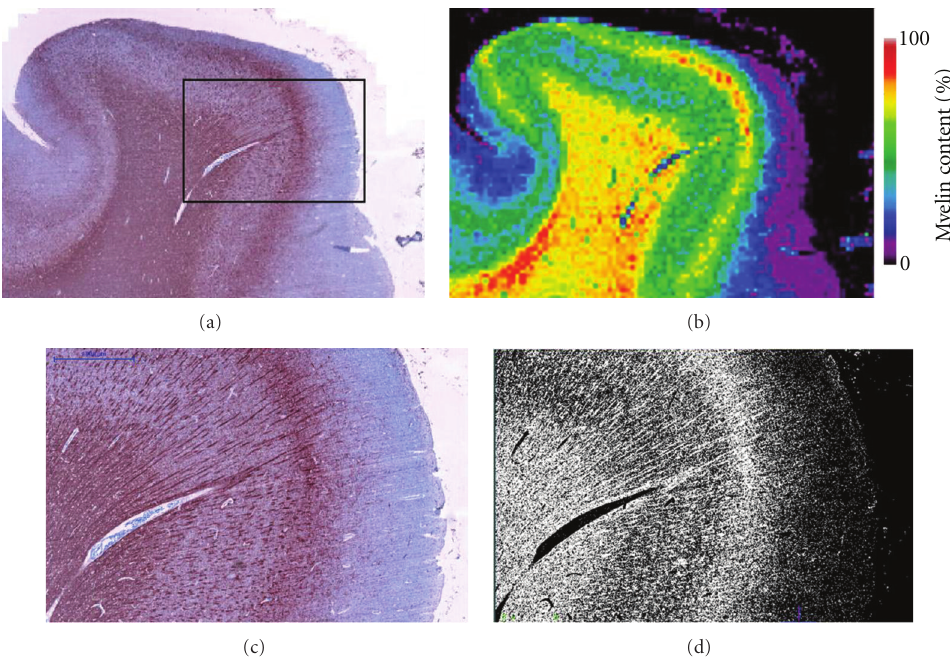
Figure 5: (a) MBP-stained section of healthy brain and (b) resulting myelin content map (0–100%). (c) Magnification of the region outlined by the black rectangle in the section in (b) and (d) binary classification of the myelin.